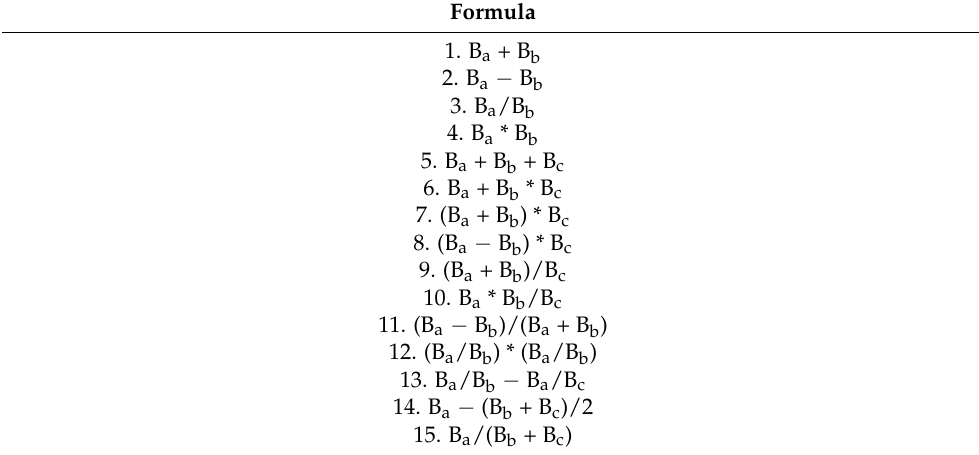
Table 2. The general formulas used in this study. B indicates the atmospherically corrected angular dependent water-leaving reflectance band, and index a, b, or c indicates different Ocean and Land Colour Instrument (OLCI) bands (15 bands in different options) or the Level-2